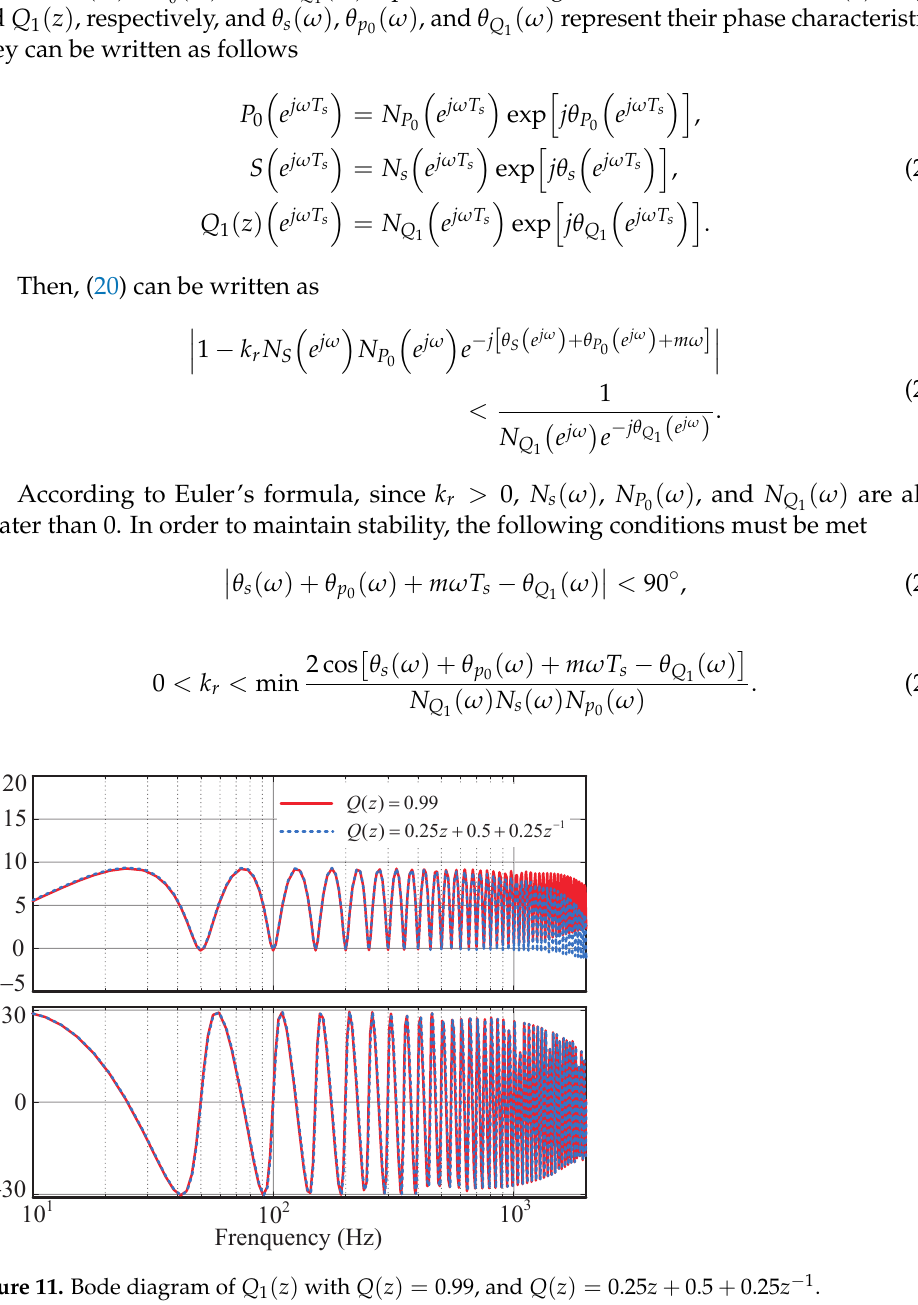
Figure 11. Bode diagram of Q 1 ( z ) with Q ( z ) = 0.99, and Q ( z ) = 0.25 z + 0.5 + 0.25 z − 1